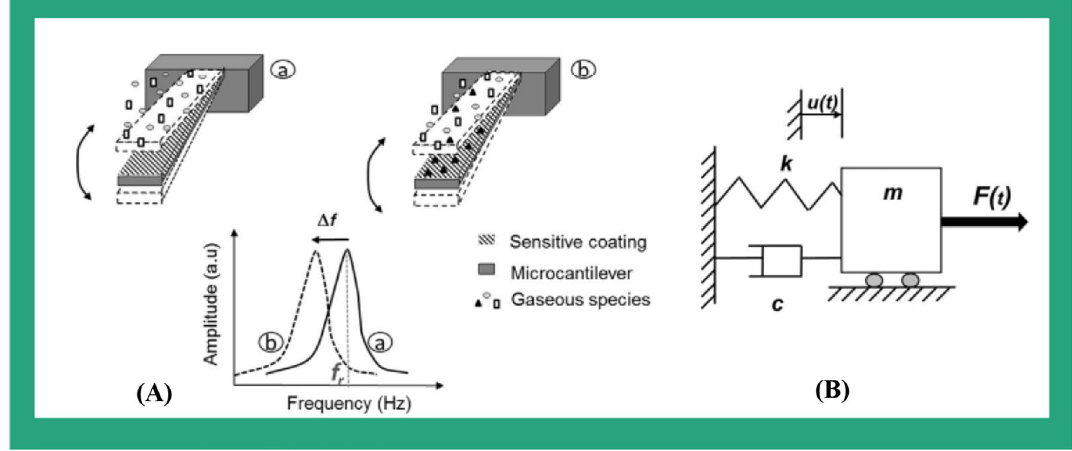
Fig. 8 Illustration of microcantilever utilized as chemical sensors. ( A ) presents the microcantilever detection scheme, ( B ) shows the mass- spring-dashpot system equivalent to the vibrating microcantilever